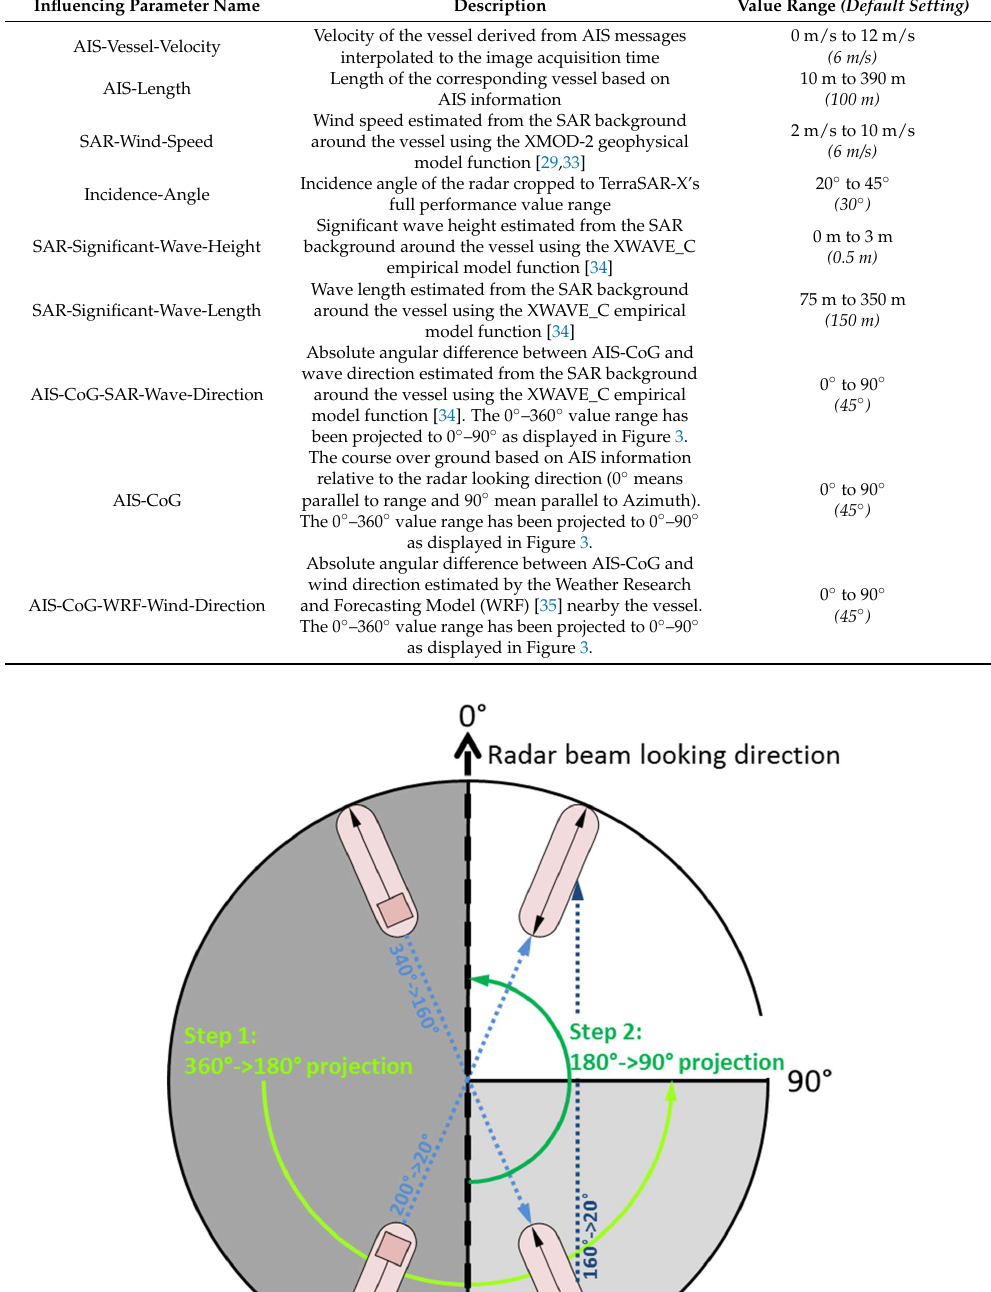
Table 1. List of the nine influencing parameters considered in the detectability model along with a description and the value range, in which all samples in the training dataset lie; also a default parameter setting used for the plots in Section 3 is provided.